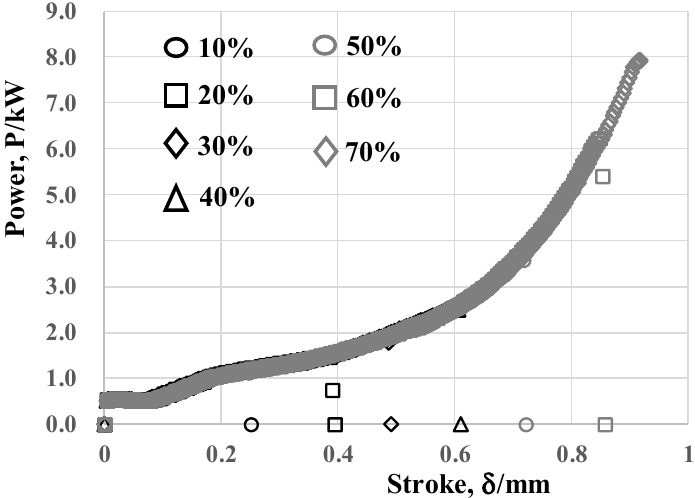
Figure 7. Power to stroke relationship in dry cold forging of pure titanium wire at the reduction in diameter by r = 10%, 20%, 50%, and 70%.